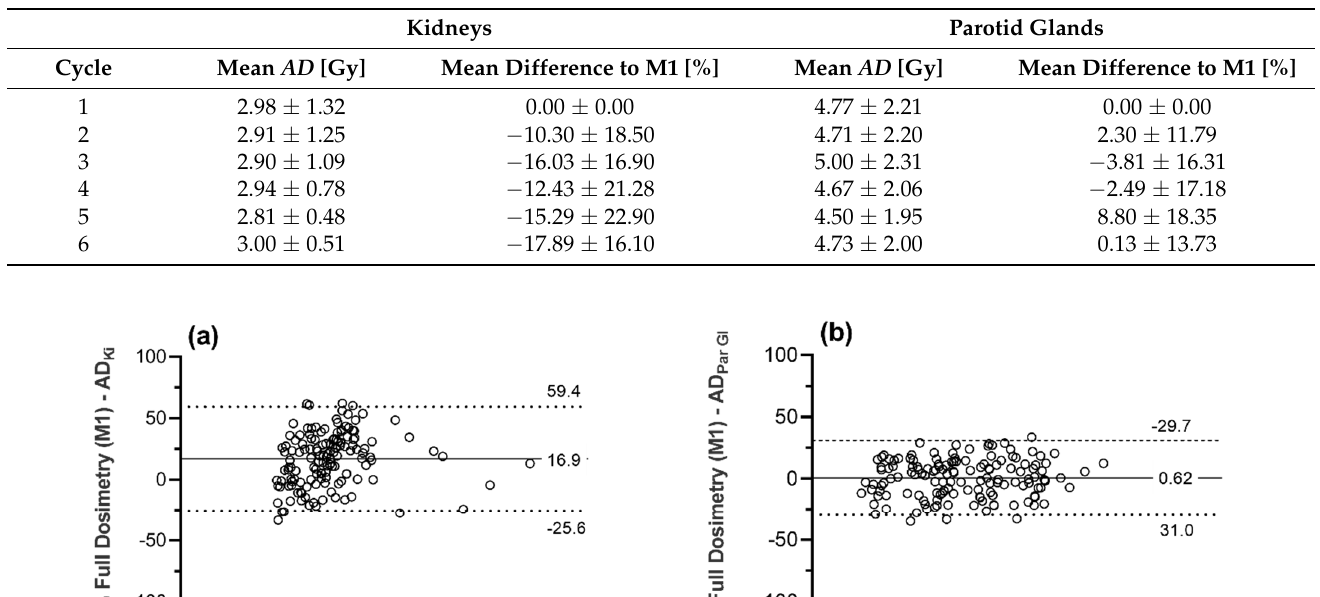
Table 5. Comparison of the derived AD to kidneys and parotid glands using method 3 and mean difference to the results using method 1. Data are given as mean ± SD.